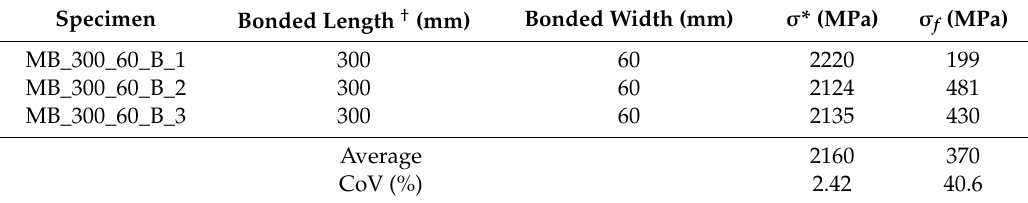
Table 3. Results of quasi-static monotonic modified beam tests.